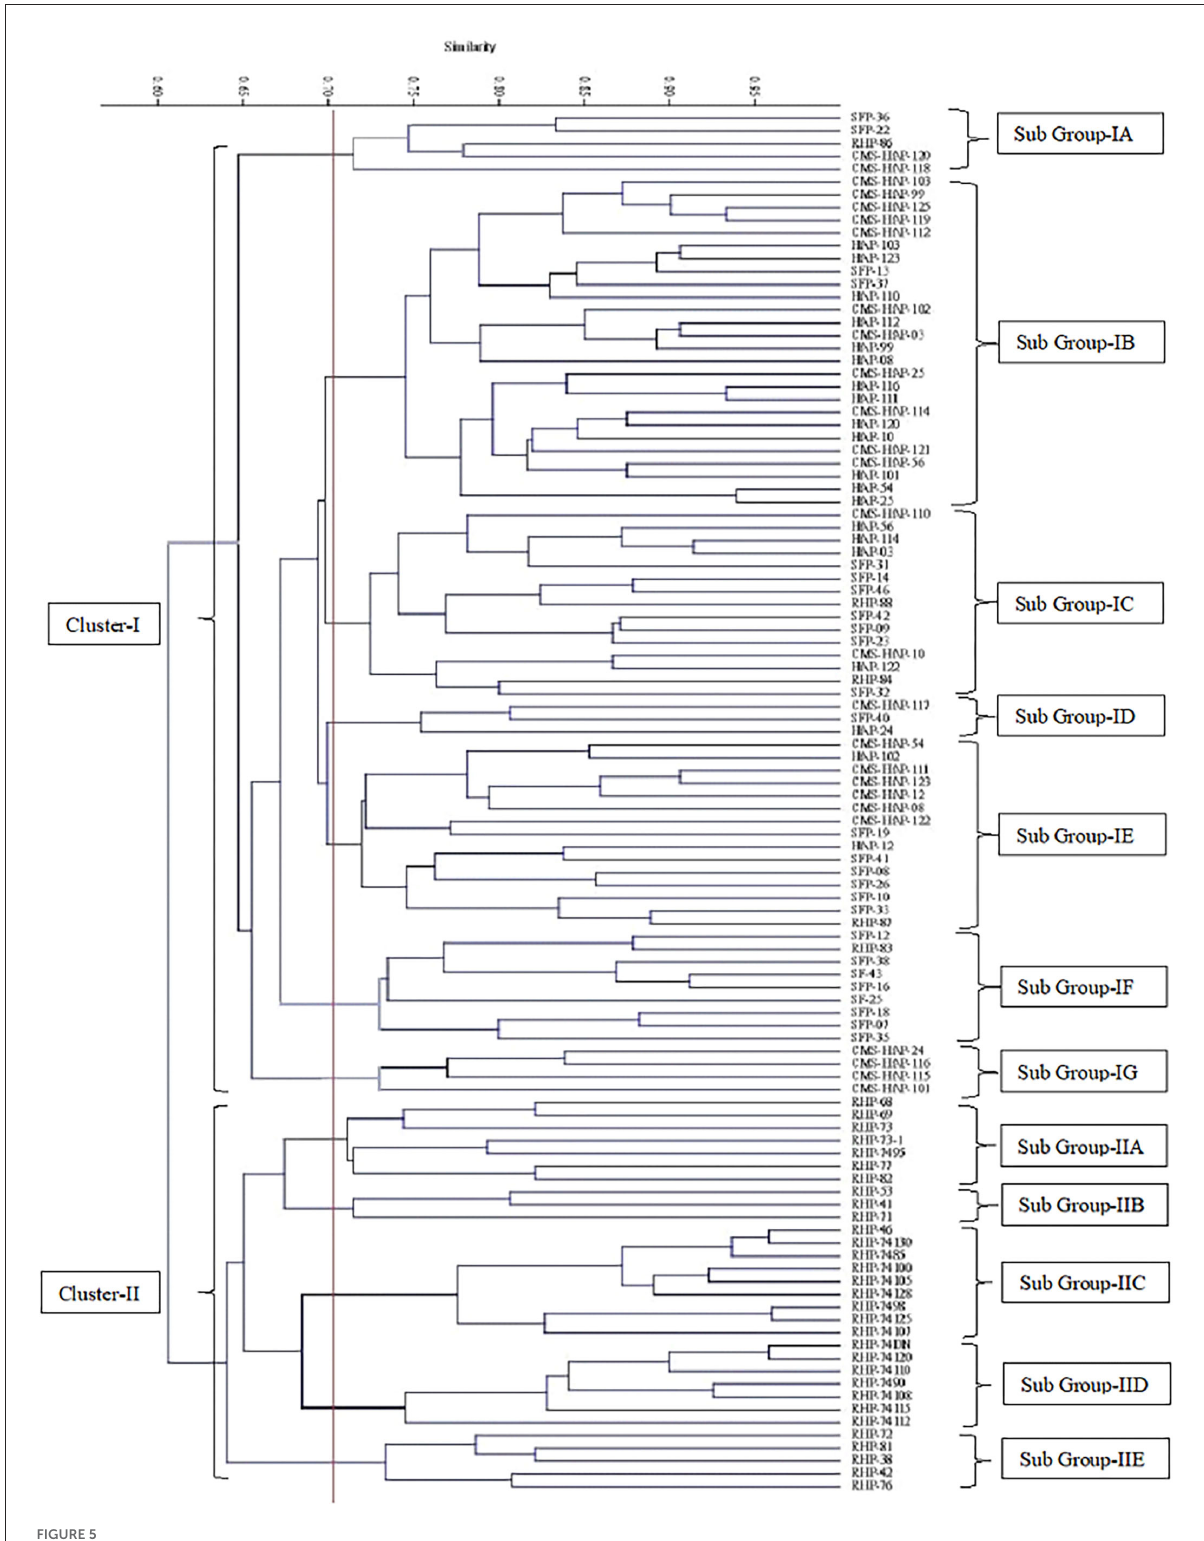
FIGURE5 Cluster diagram constructed on 40 SSR molecular markers data of 109 sunflower